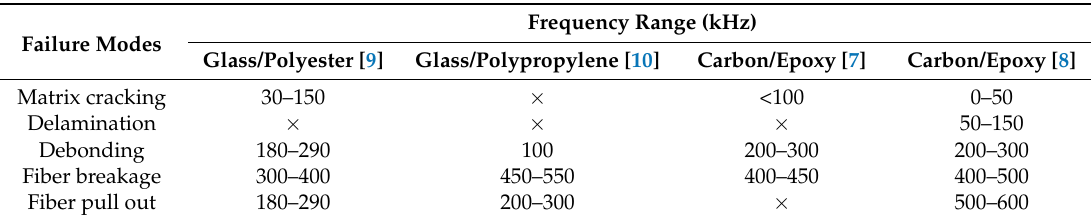
Table 1. Frequency analysis